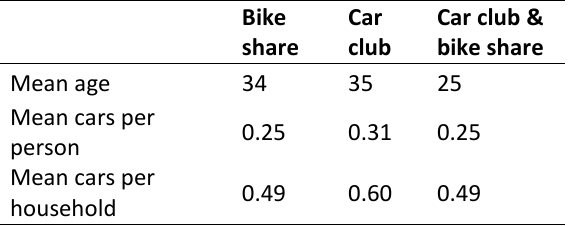
Table 2. Mean age and cars per person and household for those living within 400m of shared car and bicycle